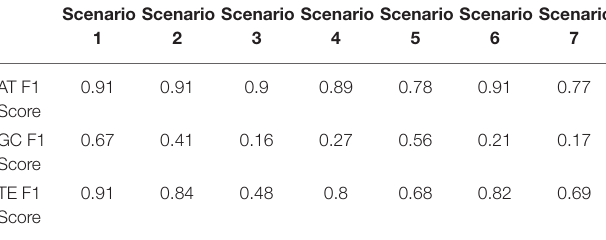
TABLE 1 | F1 scores of Acceleration Transfer (AT), Granger Causality (GC), and Transfer Entropy (TE) measures on seven mixed policy